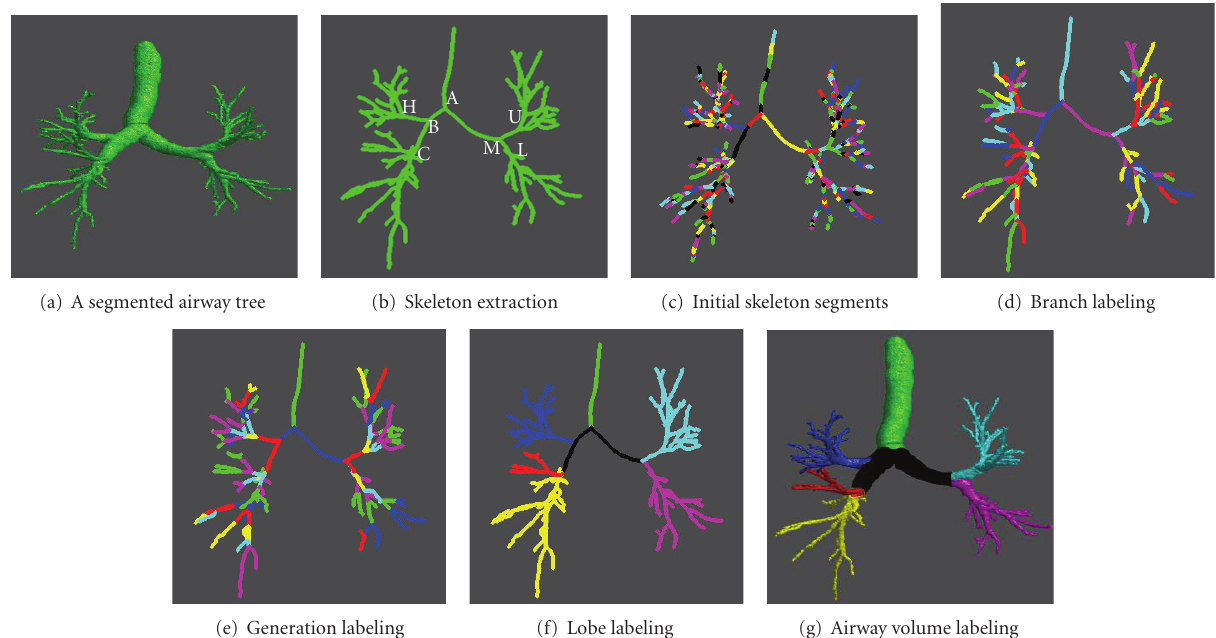
Figure 2: An example used for illustrating the steps of the labeling algorithm: (a) a segmented airway tree that can be obtained using any airway segmentation algorithm, (b) the extracted skeleton/centerline of (a) in the form of point/voxel, (c) skeleton segments obtained by the algorithm of [18], (d) individual branch labeling (in di ff erent colors), (e) di ff erent generation labeling (in di ff erent colors), (f) lobe labeling (trachea, RUL, RML, RLL, LUL, LLL are colored with green, blue, red, yellow, cyan, and magenta, resp.), (g) airway tree volume